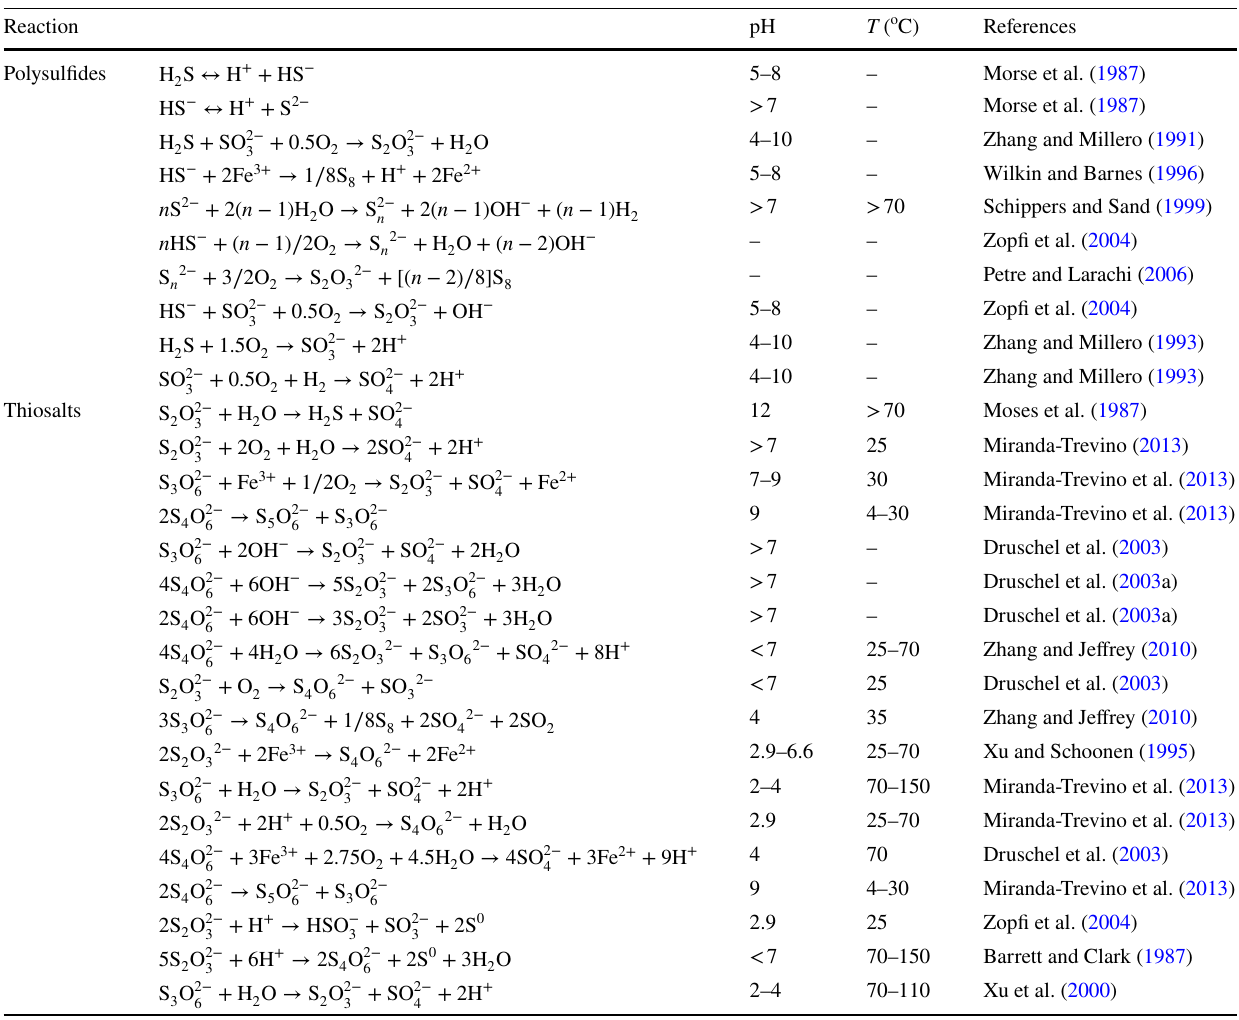
Table 1 Summary of sulfur reactions from the literature under both acidic and basic conditions